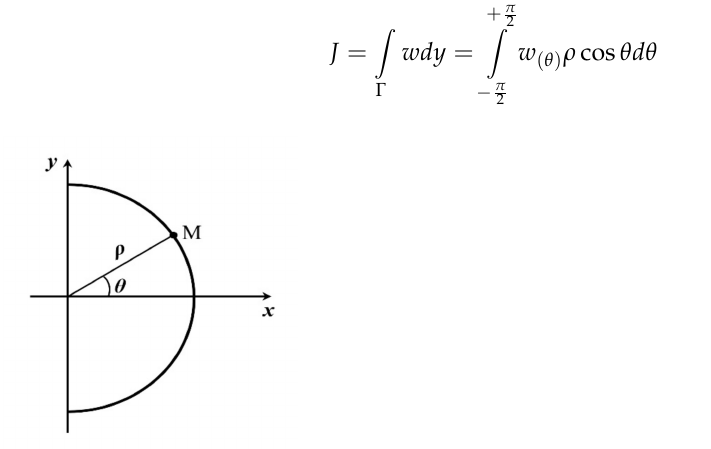
Figure 2. Polar co-ordinates of a point on the semicircular periphery of the